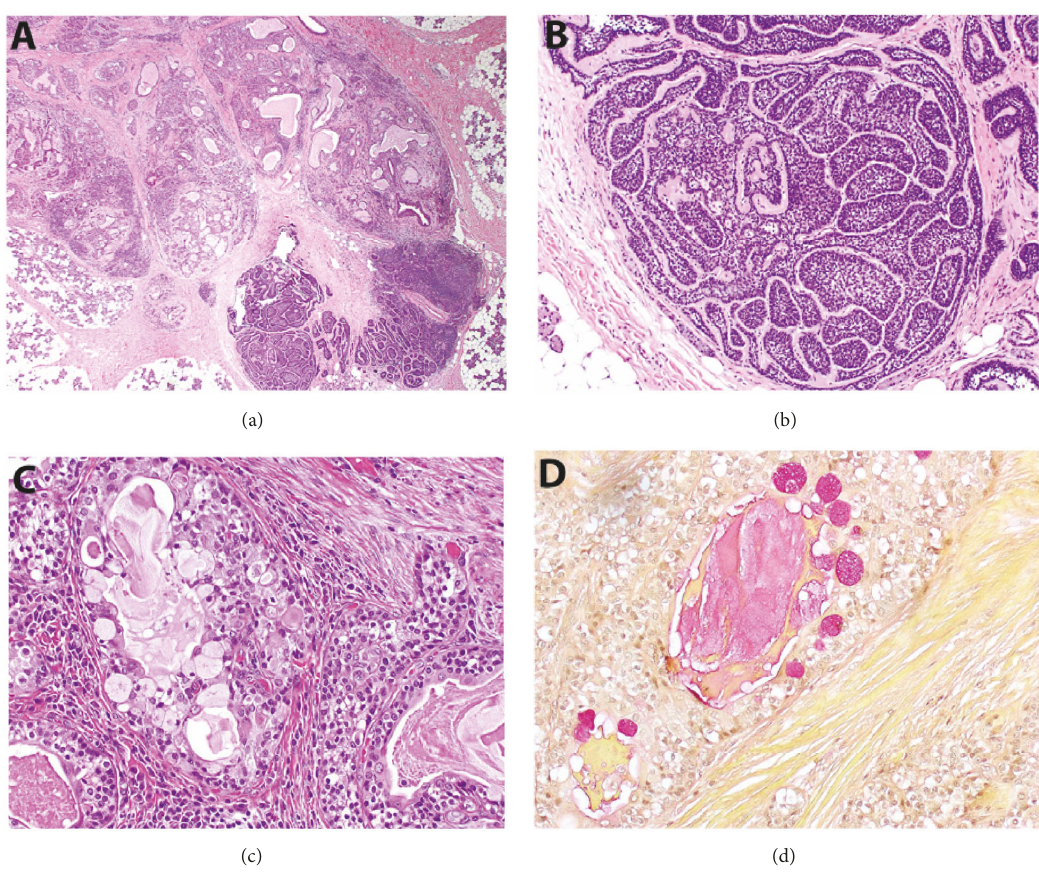
Figure 1: Histopathological findings of theparotid gland mass. (a)Alow-powerviewshows two morphologically distinctlesions immediately adjacent to each other: mucoepidermoid carcinoma (upper left) and basal cell adenoma (lower right) with a sharp transition between the two components. (b) The basal cell adenoma component demonstrates jigsaw-like nests of basaloid cells surrounded by a ribbon-like rim of eosinophilic hyaline material. (c) The mucoepidermoid carcinoma component shows numerous plump mucocytes with finely granular clear cytoplasm as well as polygonal epidermoid cells and intermediate cells. (d) A mucicarmine special stain confirms the presence of intracytoplasmic and extracellular mucin associated with the lesional cells of the mucoepidermoid